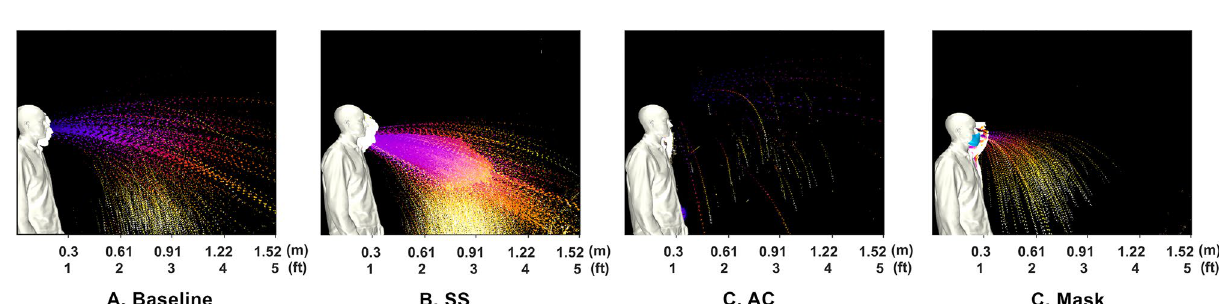
Figure 7. Summary of droplet exposure from Human Sneeze with various saliva-content modifiers. Cases compare ( a ) baseline saliva, ( b ) SS, ( c ) AC, and ( d )